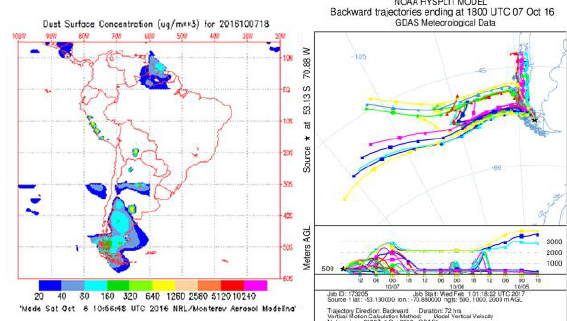
Figure 3 NAAPS forecasting analysis and HYSPLIT for the days 07 October 2016 at 18:00 UTC. panel and the right panel shows the HYSPLIT back trajectories for the same